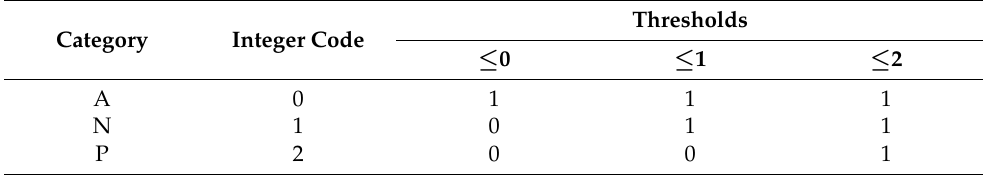
Table 5. Binarizing categorical features in the Bankruptcy